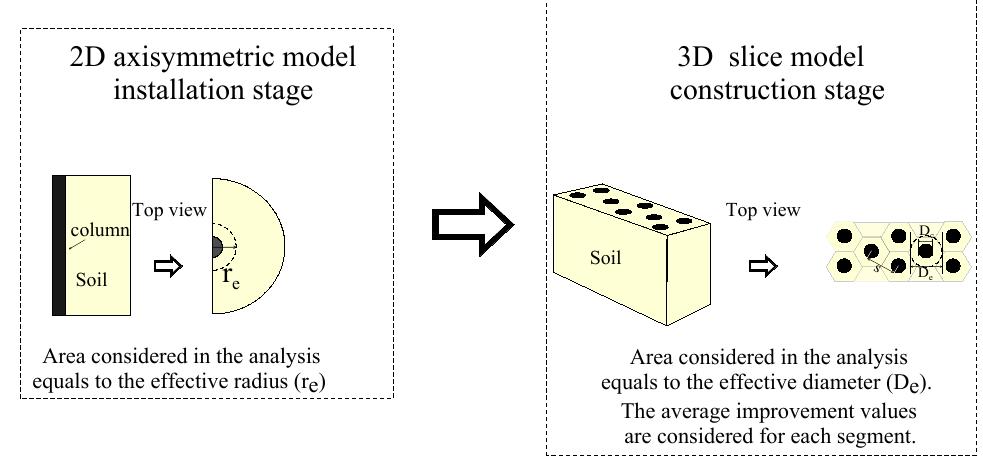
Figure 3. Details of the concept adopted in numerical